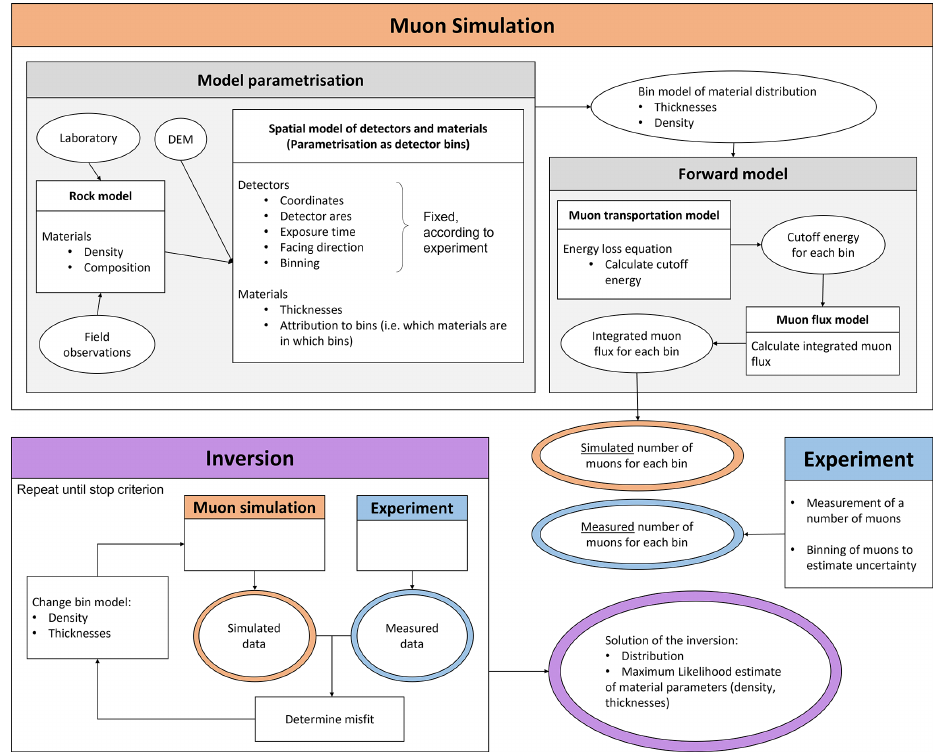
Figure 2. A schematic flowchart showing the different involved models in a muon tomographic experiment. The muon simulation consists of a model for rocks, detectors, the cosmic-ray flux and a particle physical model on how muons lose energy upon travelling through rocks. These models allow for a synthetic dataset to be computed. The systematic comparison between synthetic data and actual measured data, and the subsequent change of the model parameters to find the set of parameters that reproduce the measured data best is an (often iterative) optimisation problem. This procedure is termed “inversion” (usually) by